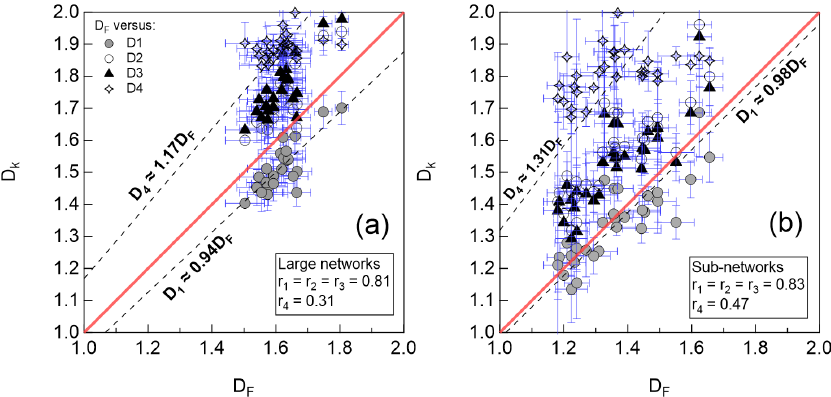
Figure 8. Comparison between D F and D 1 , . . . , D 4 for ( a ) large and ( b ) sub-networks. The correlation index r k of each distribution was also included for reference. Linear fits are given by the equations D 1 = α D F and D 4 = β D F , where α and β are free fitting parameters. Vertical and horizontal error bands for each data were also